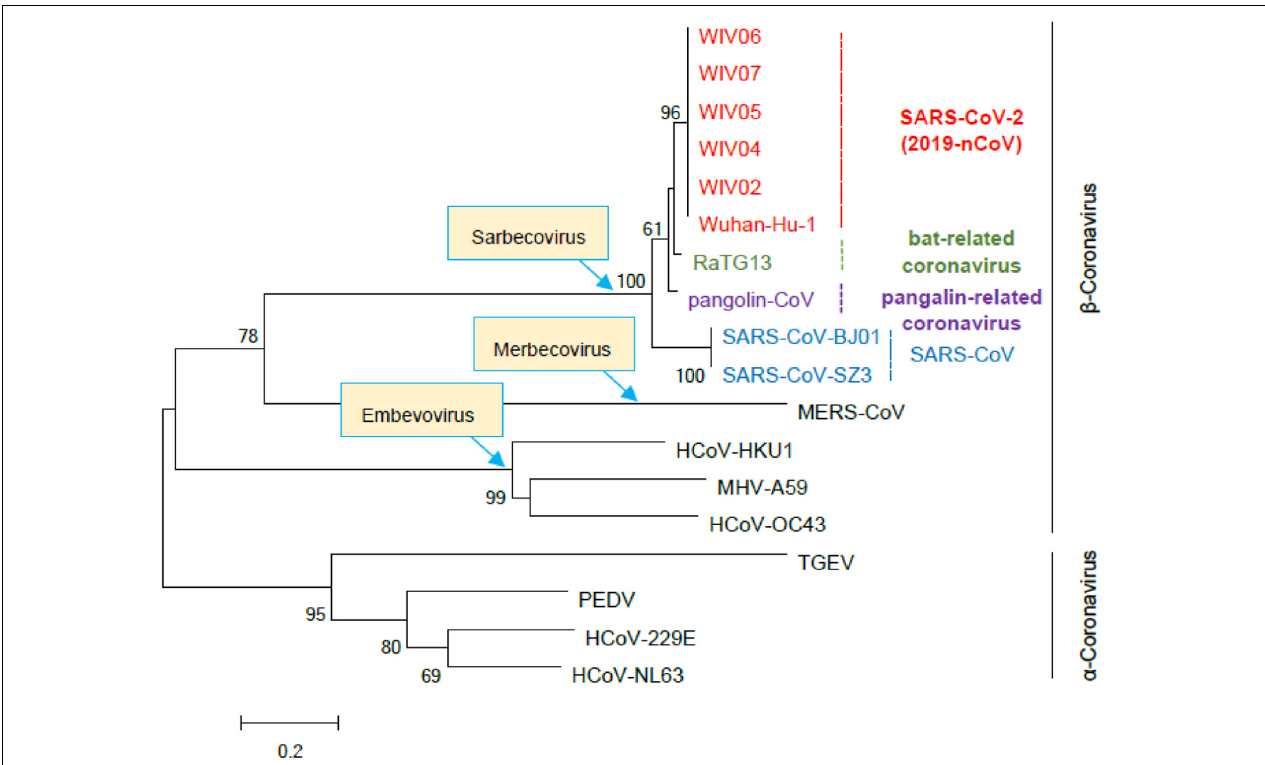
FIGURE 2 | Phylogenetic tree based on the amino acid sequences of β - and α -CoV nsp1. The nsp1 sequences of the indicated representative β - and α -CoVs were collected and aligned with MEGA 6.0. The phylogenetic tree was constructed by the Neighbor-Joining algorithm with MEGA 6.0 and tested with 1000 bootstrap replicates. Numbers on the tree indicate percentage bootstrap values ( > 50%) for the associated nodes. The scale bar represents the number of substitutions per site. Accession numbers of the sequences used for analysis are as follows: SARS-CoV-2 strains Wuhan-Hu-1 (EPI_ISL_402125), WIV02 (EPI_ISL_402127), WIV04 (EPI_ISL_402124), WIV5 (EPI_ISL_402128), WIV6 (EPI_ISL_402129), and WIV7 (EPI_ISL_402130); SARS-CoV strains BJ01 (AY278488) and SZ3 (AY304486); bat-related coronavirus RaTG13 (EPI_ISL_402131); pangolin-related coronavirus (pangolin-CoV, EPI_ISL_410721); Middle East respiratory syndrome